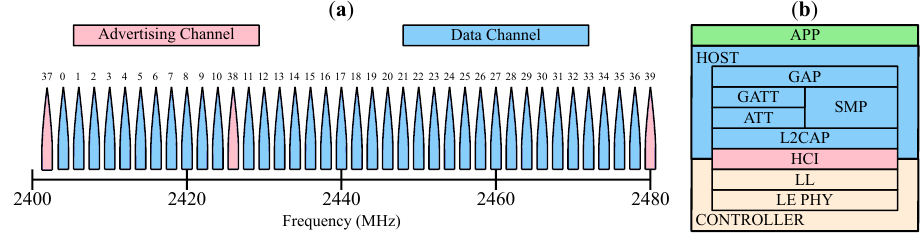
Figure 3. ( a ) BLE channel spacing. ( b ) BLE stack.